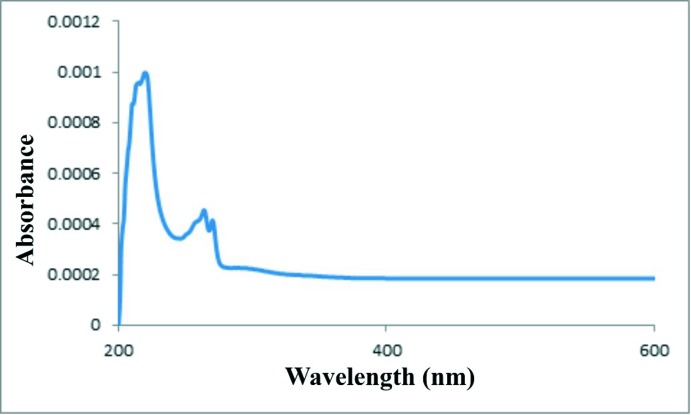
UV–vis spectrum of C21H23F2NO